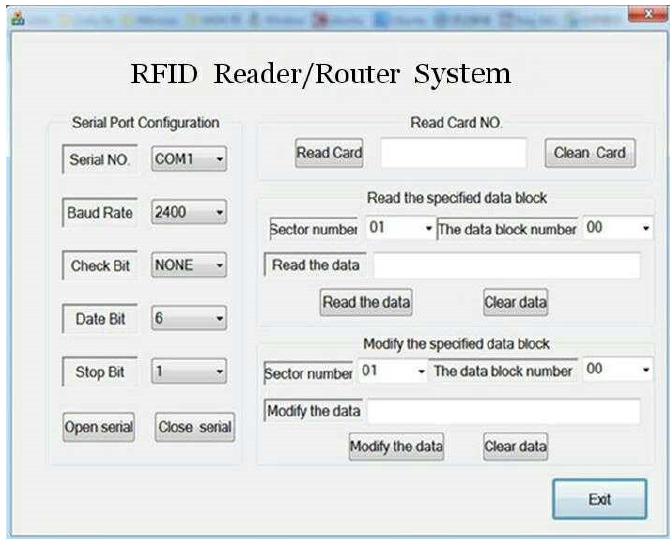
Figure 10. RFID reader/router application software.